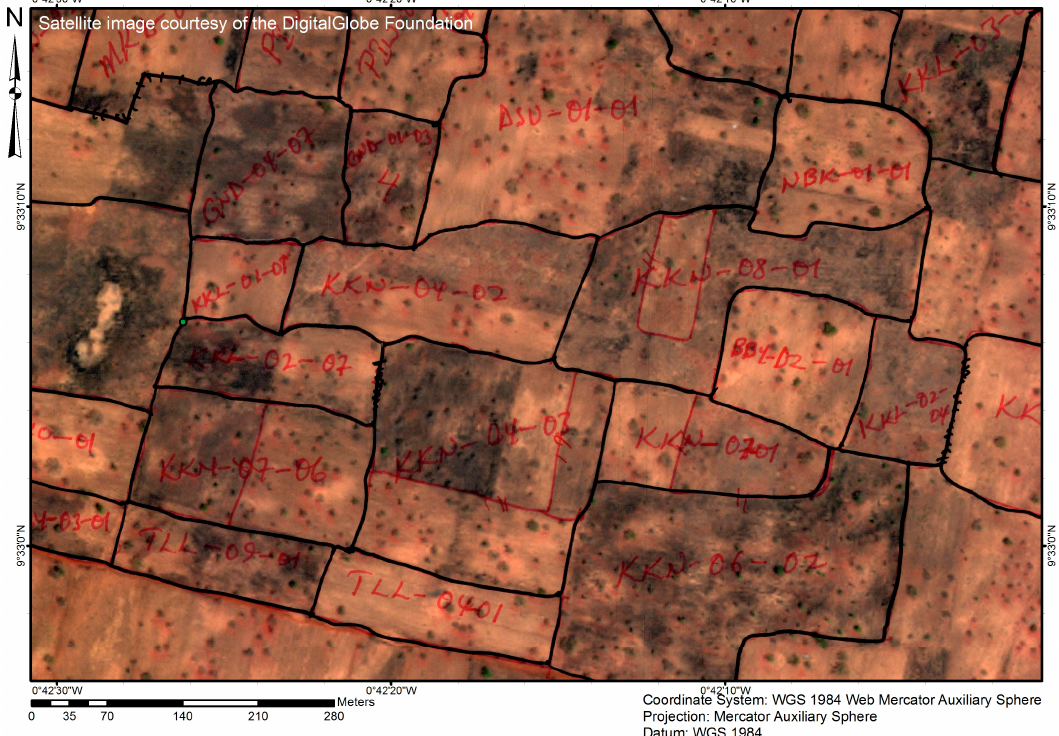
Figure 3. Part of the satellite image from the farm parcel identification showing Red Lines that are parcels identified by farmers and Black lines being parcels verified by the Trusted Intermediaries.